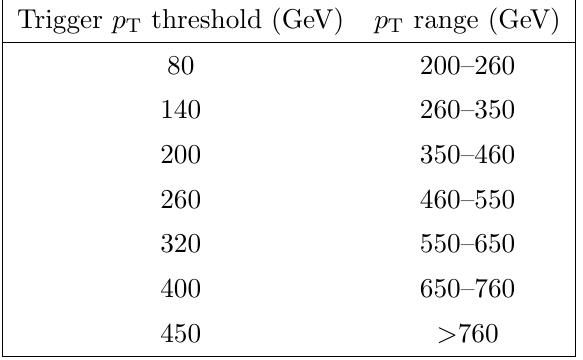
Table 1 . List of trigger thresholds used for each high-level trigger path. The ungroomed jet p T ranges are shown in the second column. Events are selected such that exactly one fully e(cid:14)cient trigger is used for each p T